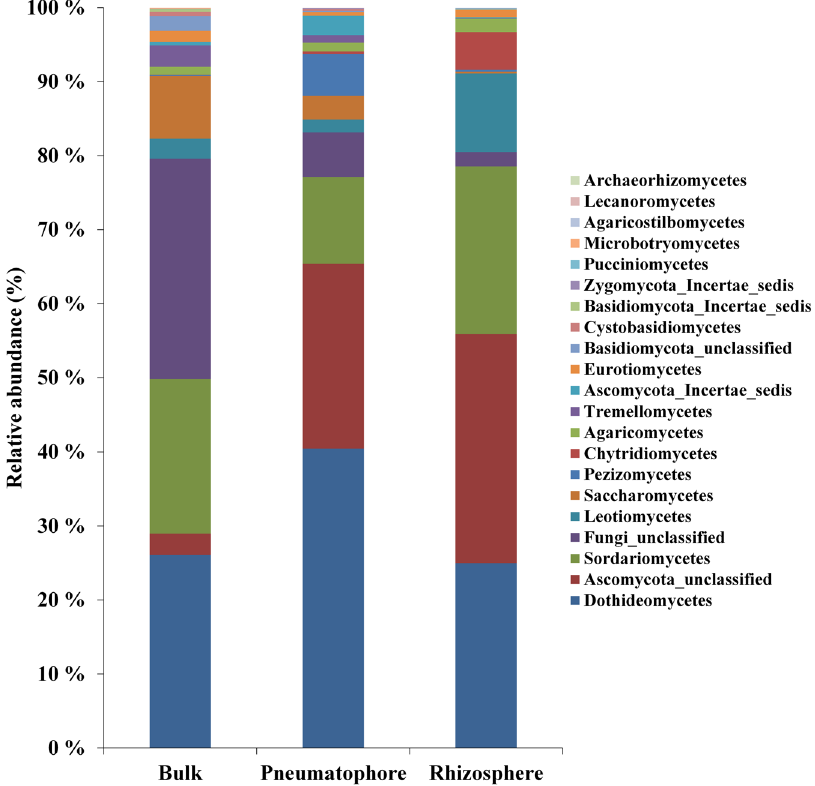
Figure 2. Class level distribution based on fungal ITS sequences of bulk, pneumatophore, and rhizosphere soil compartments. Values are mean of five replicates from each sample. OTUs were clustered at 97% similarity